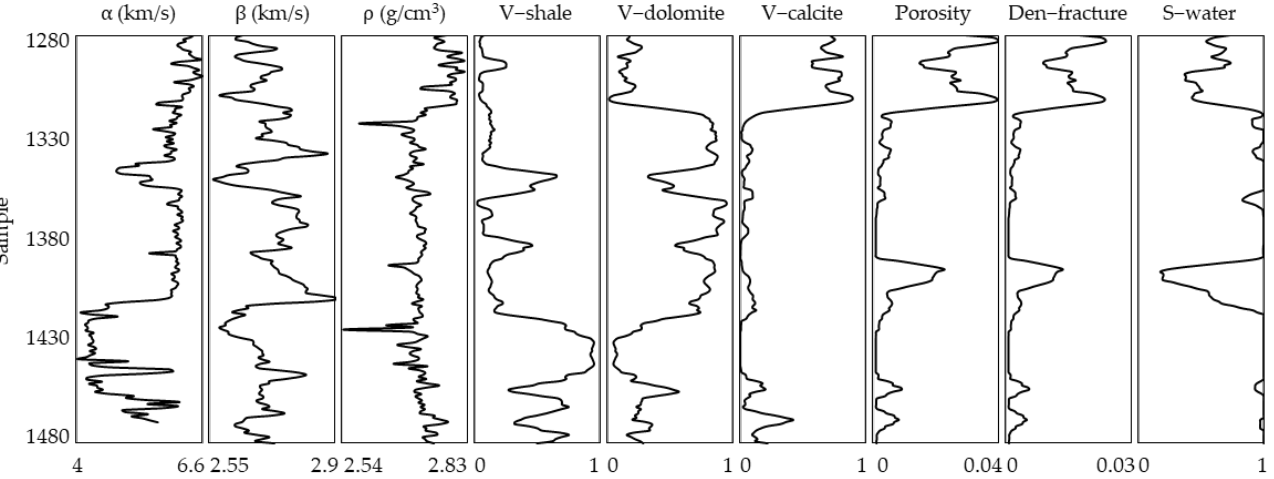
Energies 2021 , 14 , x FOR PEER REVIEW Figure 6. The well logging data of a fractured model which is ready to calculate the attenuated and anisotropic parameters.